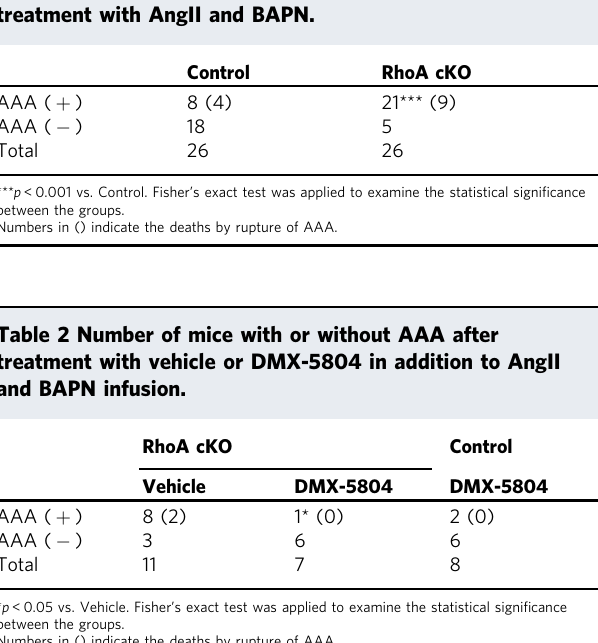
Numbers in () indicate the deaths by rupture of